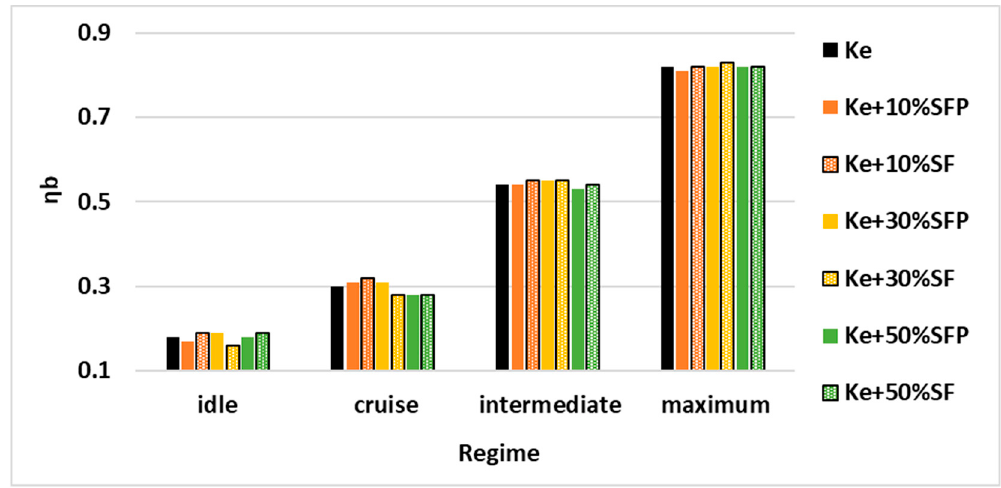
Figure 14. Variation of combustion efficiency for all the four regimes and for all the tested fuel blends.